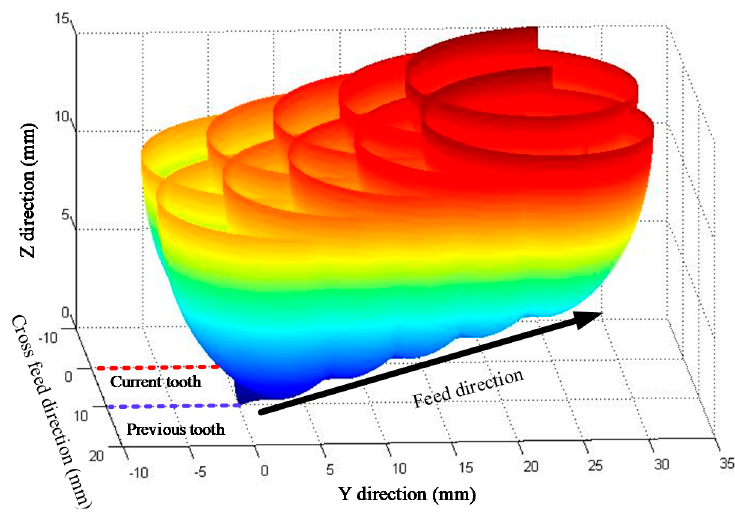
Figure 3. Swept surfaces of one cutting edge along two adjacent tool paths.